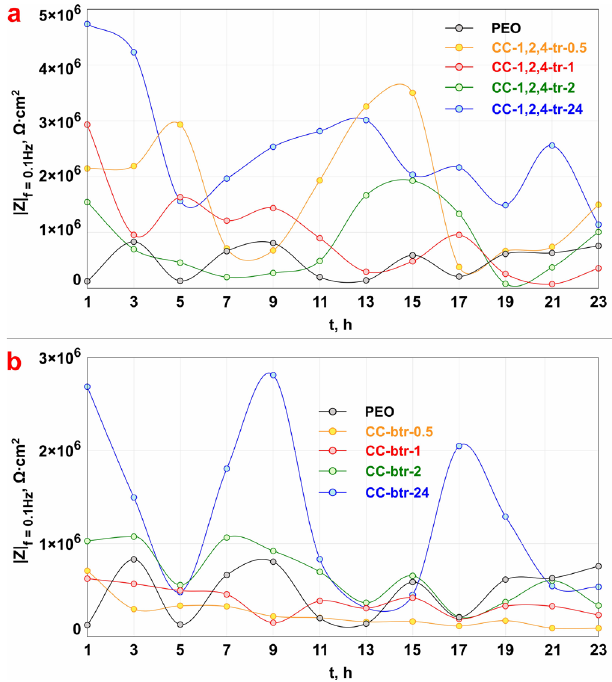
Figure 9. Evolution of |Z| f = 0 . 1 Hz values for samples with 1,2,4 - triazole - ( a ) and benzontriazole ( b ) containing coatings during 24 h of exposure to 3.5 wt.% NaCl solution .